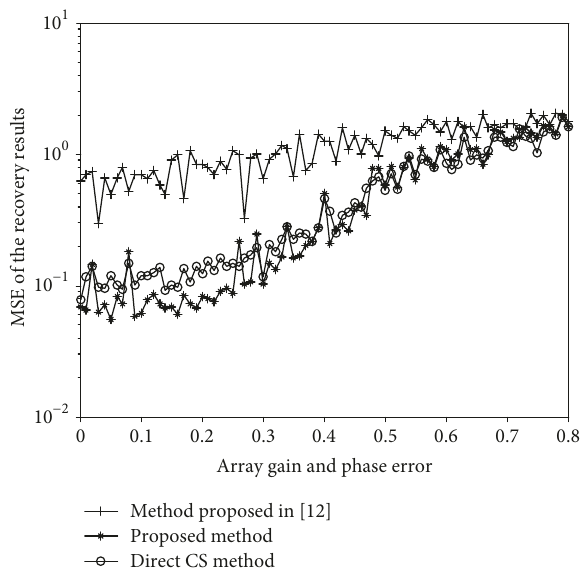
Figure 4: Comparison of the performance of sparse recovery